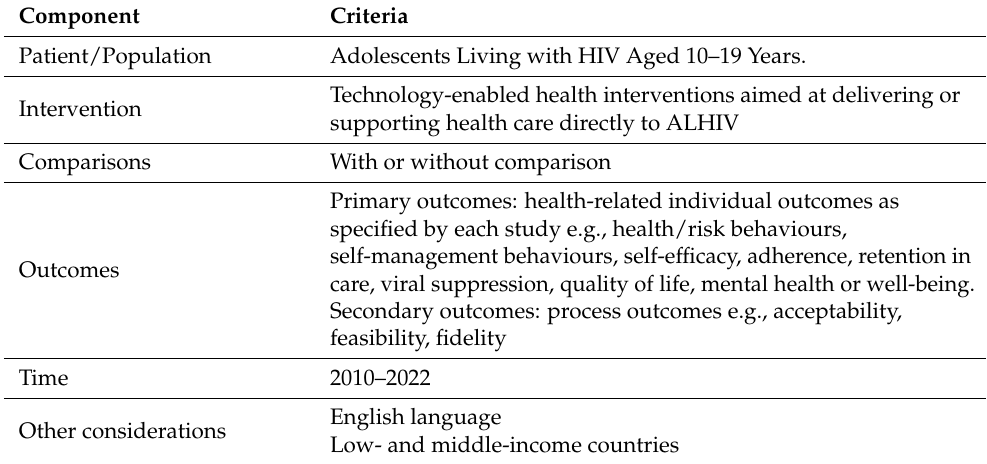
Table 1. PICOT- criteria for inclusion of